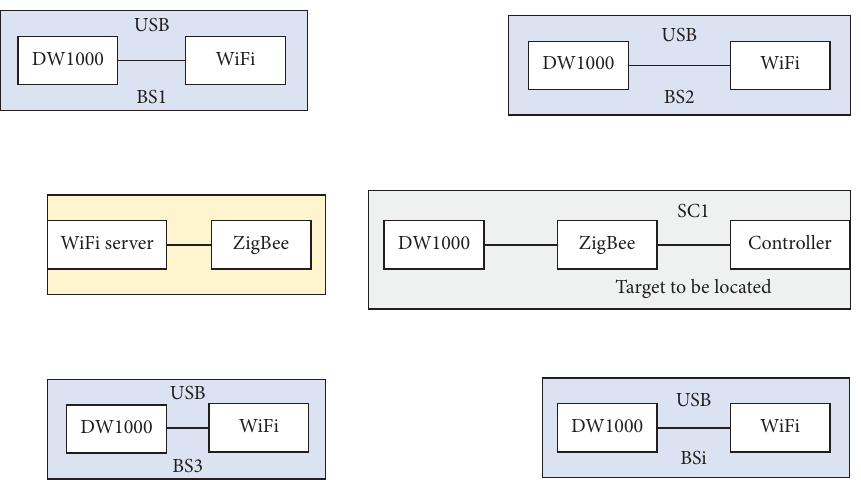
Figure 3: Schematic diagram of the UWB positioning